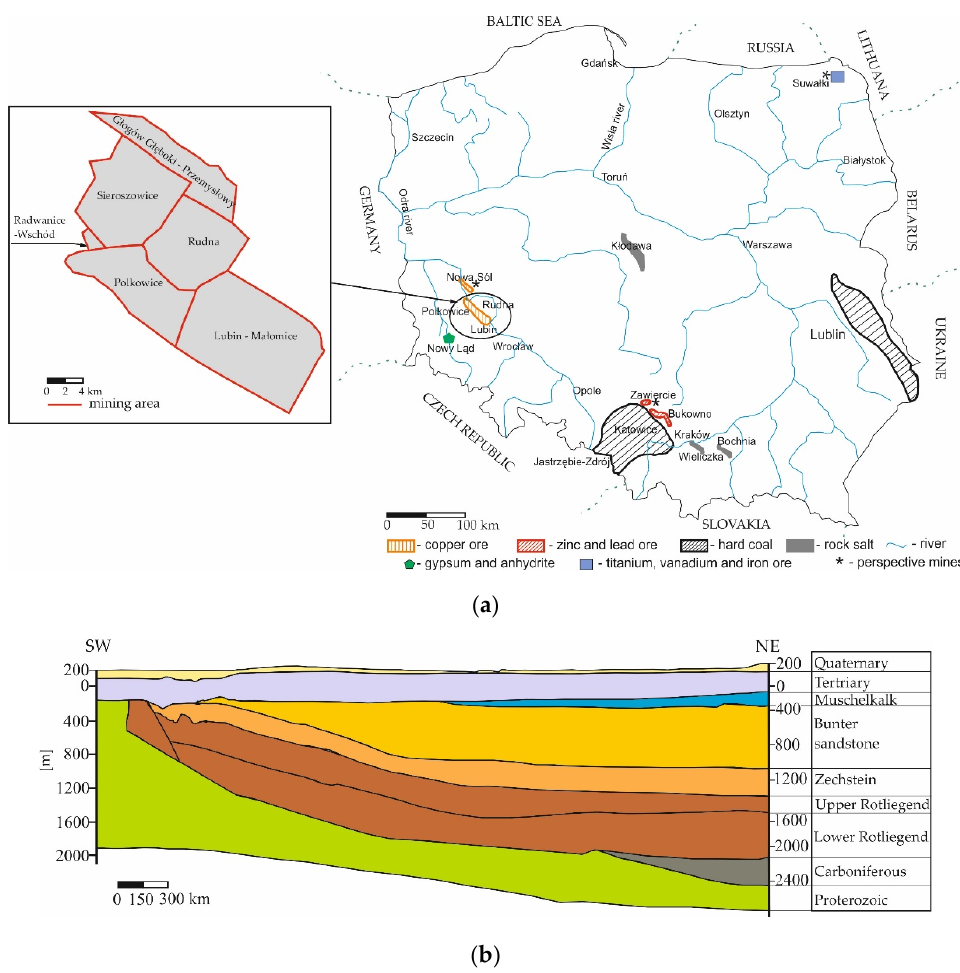
Figure 1. Location of current and prospective underground mines in Poland with particular emphasis on Legnica-G ł ogów Copper District: ( a ) location of mining areas; ( b ) geological cross section of copper ore deposit in Fore–Sudetic Monocline.